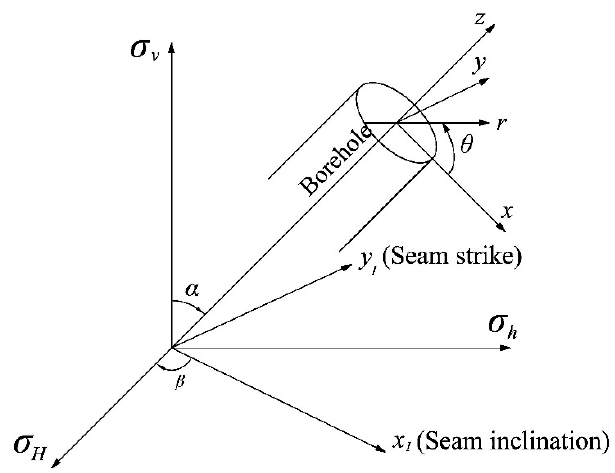
Figure 2. Diagram showing the stress state in a hydraulic fracture borehole wall when the borehole is perpendicular to the coal seam.